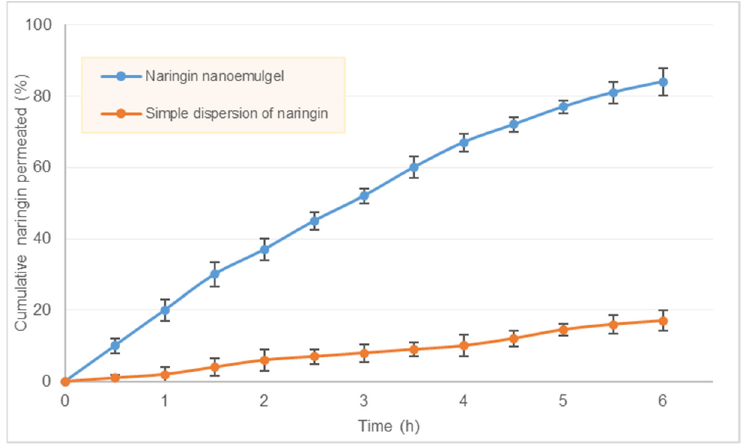
Figure 6. Ex vivo permeation profile of in situ gelling nanoemulgel and the simple formulation made by dispersing naringin in same vehicle. Data represent mean of 6 determinations and error bars indicate SD.